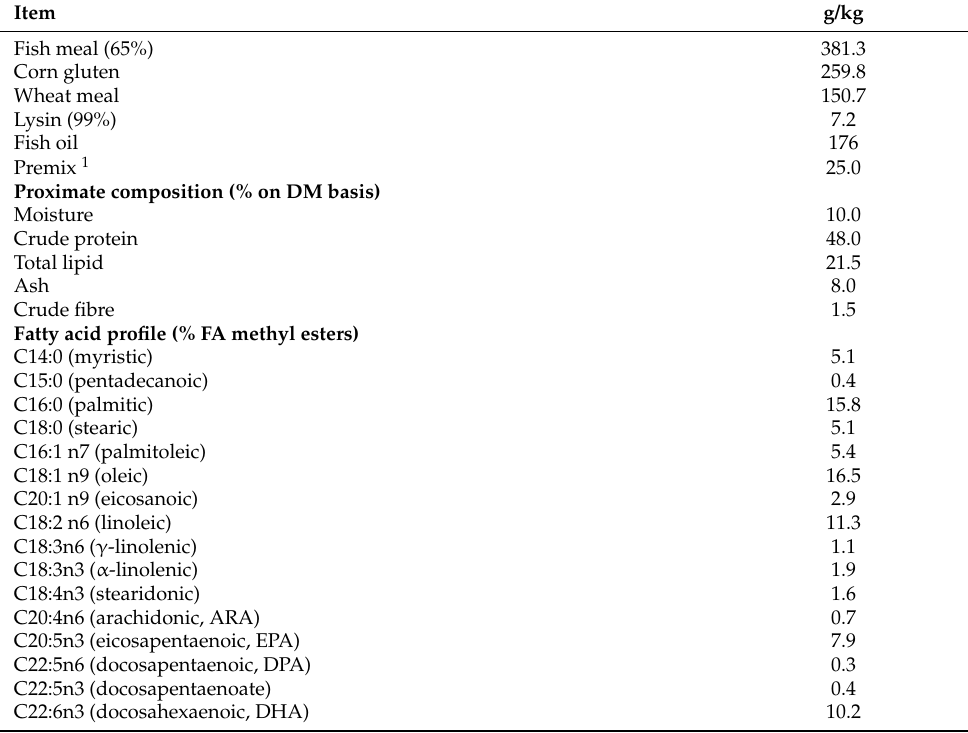
Table 1. Ingredients, chemical composition, and fatty acid profile of the conventional feed. Item Fish meal